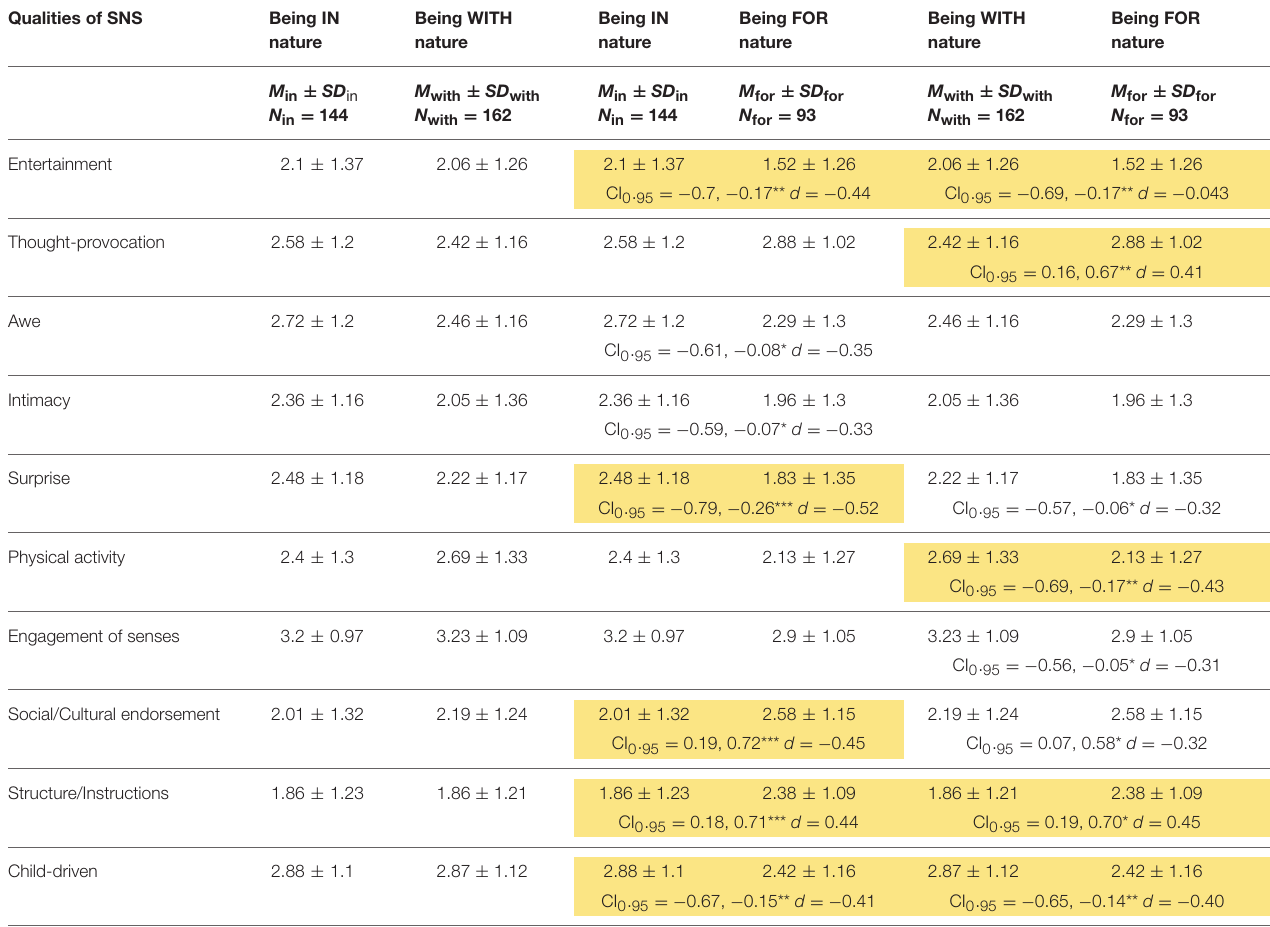
TABLE 3 | Results of Tukey post-hoc test and Cohen’s d for the qualities of SNS that were significantly different between the three phases of HNC progression (i.e., being IN nature, being WITH nature, being FOR nature). Qualities of SNS Being IN